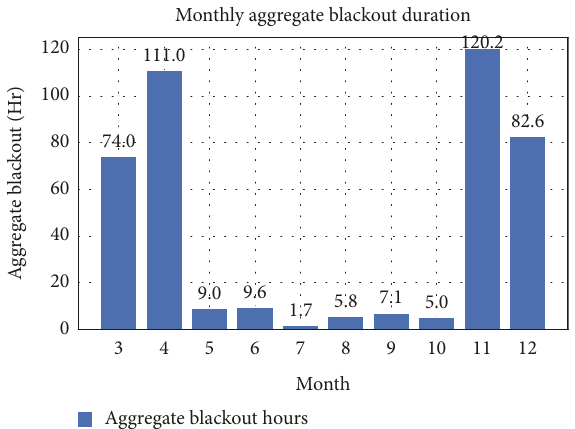
Figure 4: Monthly aggregate blackout history. March, April, November, and December had the most blackout